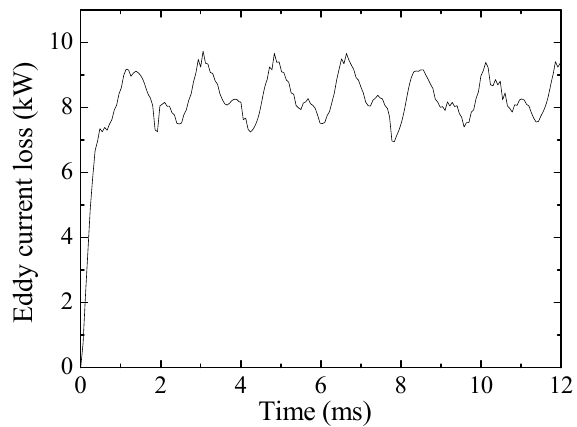
Figure 19. Simulated eddy current loss of the bracket at rated